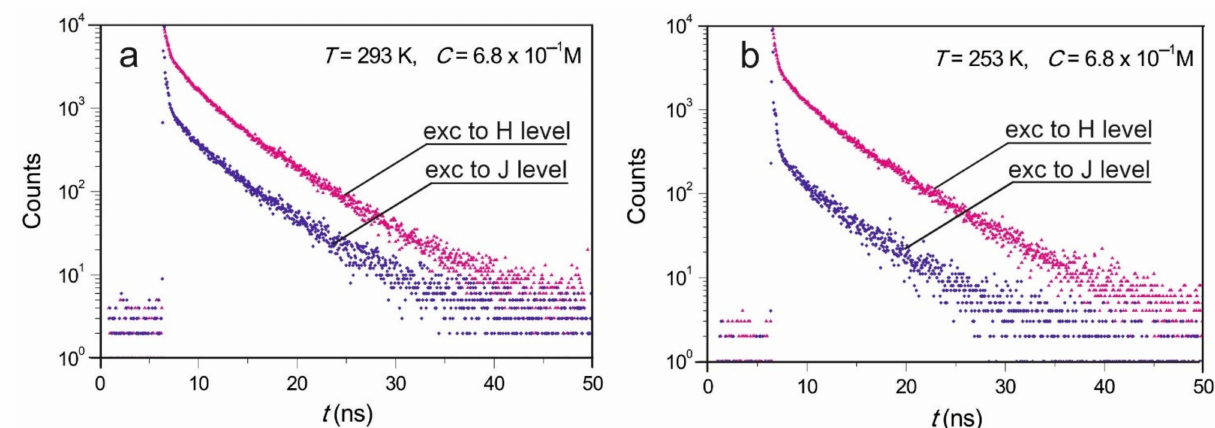
Figure 5. Fluorescence intensity decays of FMN in PVA for C = 6.8 × 10 − 1 M at T = 293 K ( a ) and T = 253 K ( b ) at two excitations wavelengths λ exc = 445 nm, λ exc = 487 nm and at observation wavelengths λ obs = 530 nm. The calculated values of mean fluorescence lifetimes are given in Table